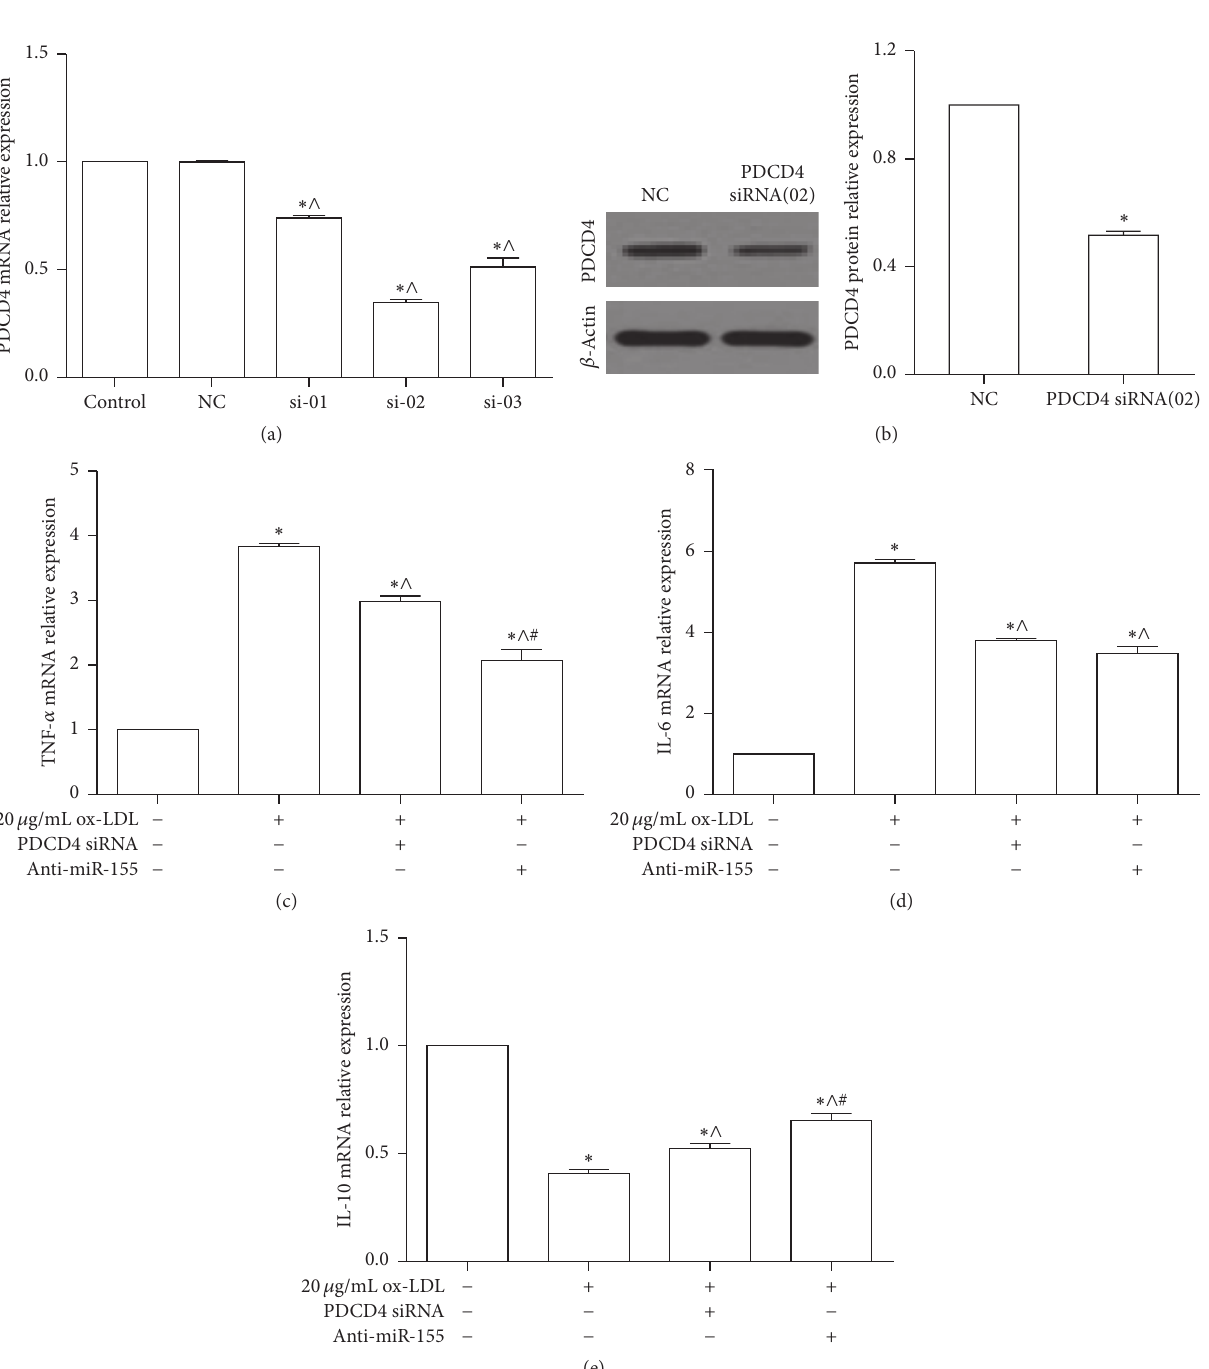
Figure 4: Downregulation of PDCD4 and miR-155 regulated the expression of IL-6, TNF- 𝛼 , and IL-10. (a) Knocking down the expression of PDCD4 mRNA by PDCD4 siRNA in macrophages RAW264.7 cells. The relative expression of PDCD4 mRNA was detected by qPCR after 50pM PDCD4 siRNA, including si-01, si-02, and si-03, and negative control (NC) was transfected into RAW264.7 cells for 48 h, respectively: ∗ 𝑝 < 0.05 versus control, ∧ 𝑝 < 0.05 versus NC group. (b) Western blot analyzed the protein level of PDCD4 when RAW264.7 cells had been treated by 50pM PDCD4 siRNA (si-02) and NC for 48h. Representative bands show the protein expression of PDCD4 (the upper bands), 𝛽 -actin (the lower bands) in left panel, and the histograms in right panel showing quantification of PDCD4 bands normalization relative to 𝛽 -actin expression in (b): ∗ 𝑝 < 0.05 versus NC group. (c, d, and e) qPCR analyzed the mRNA expression of TNF- 𝛼 , IL-6, and IL-10 in RAW264.7 cells. They were transfected into the anti-miR-155 or PDCD4 siRNA for 24 h and then treated by ox-LDL for 24 h: ∗ 𝑝 < 0.05 versus control, ∧ 𝑝 < 0.05 versus 20 𝜇 g/mL ox-LDL group, and # 𝑝 < 0.05 versus 20 𝜇 g/mL ox-LDL plus PDCD4 siRNA group. The data are presented as the mean ± SE of three separate